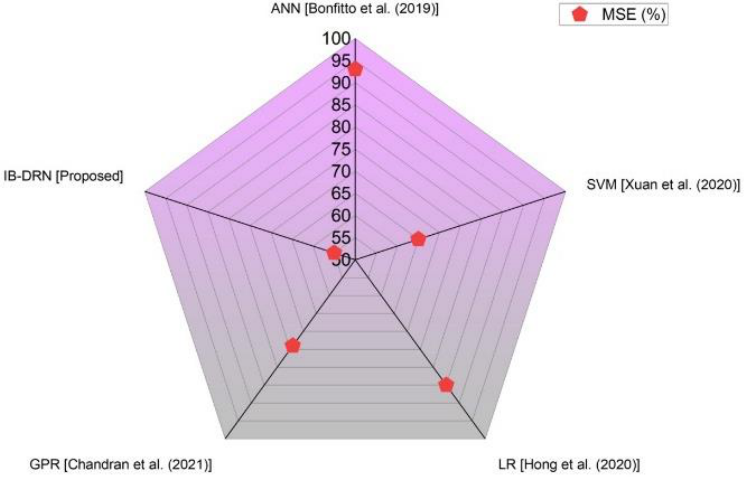
Figure 8. MSE results of the proposed and existing methodologies [ANN [Bonfitto et al. (2019)], SVM[Xuan et al. (2020)], GPR [Chandran et al. (2021)], LR[Hong et al. (2020)]].